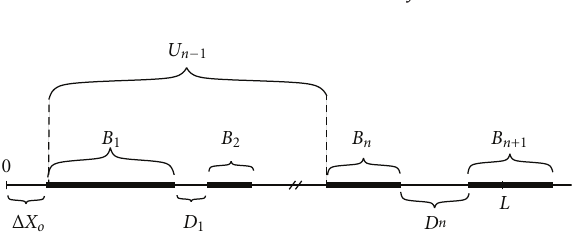
Figure 3: Illustration of the condition equivalent to β 0 ≥ n